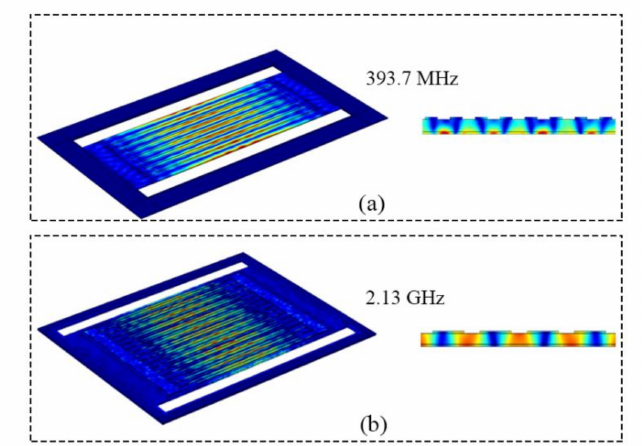
Figure 2. Simulated displacement-field distributions of the two LWRs with the IDT periods of ( a ) 12 µ m and ( b ) 2 µ